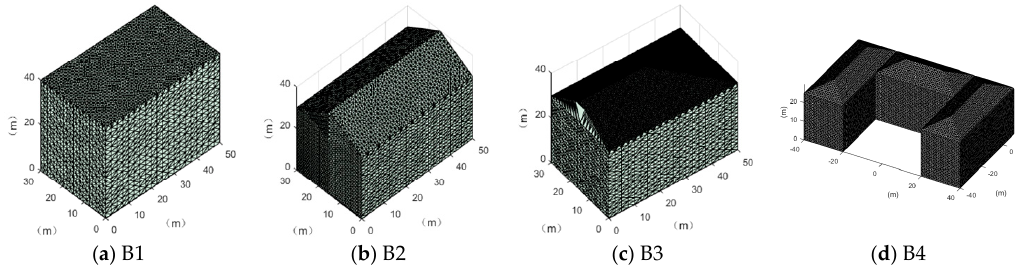
Figure 3. Typical simulated 3D buildings. ( a – c ) are three single buildings with different roofs; ( d ) is a combined one. Table 1. Typical buildings (unit: m).